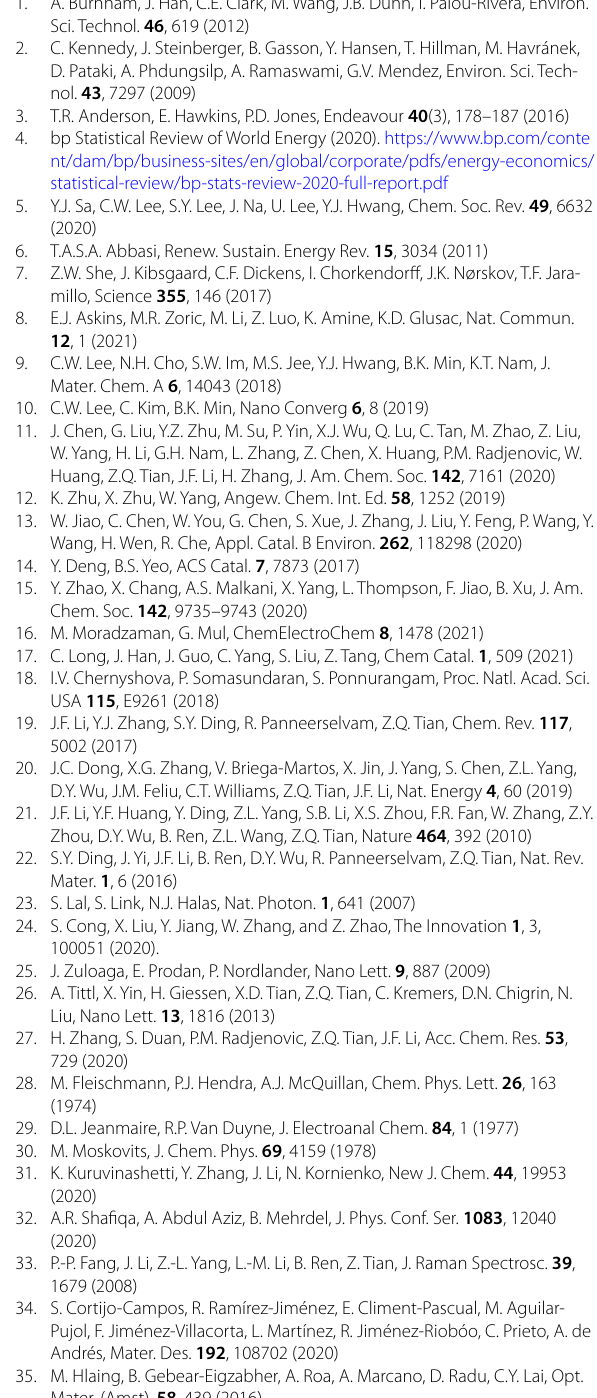
RR on the Cu(100) 3